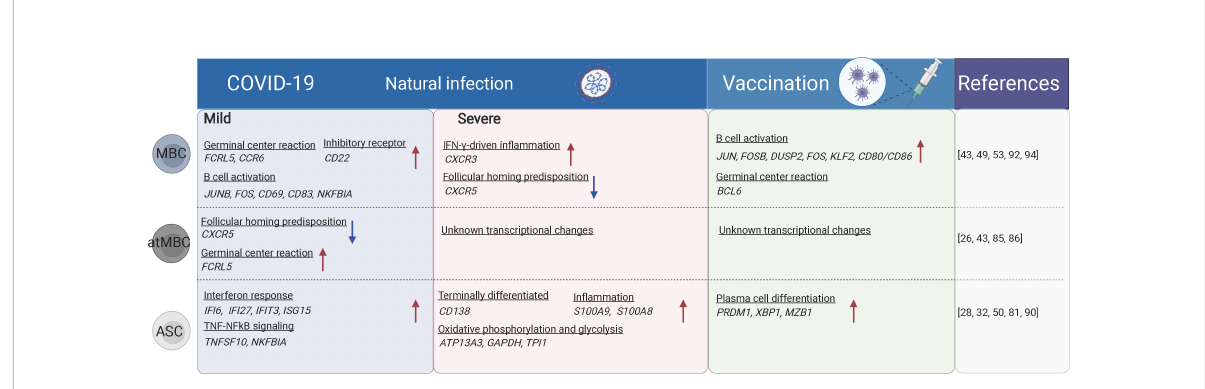
FIGURE 2 The B cell subsets and their transcriptional changes after SARS-CoV-2 vaccination and infection. The red arrows indicate the genes or pathways that were up-regulated in individuals with COVID-19 or vaccinated compared to the healthy donors, while blue arrows indicate the genes or pathways that were down-regulated. MBC, memory B cells; atMBC, atypical memory B cells; ASC, antibody secreting cells. The fi gure was created using